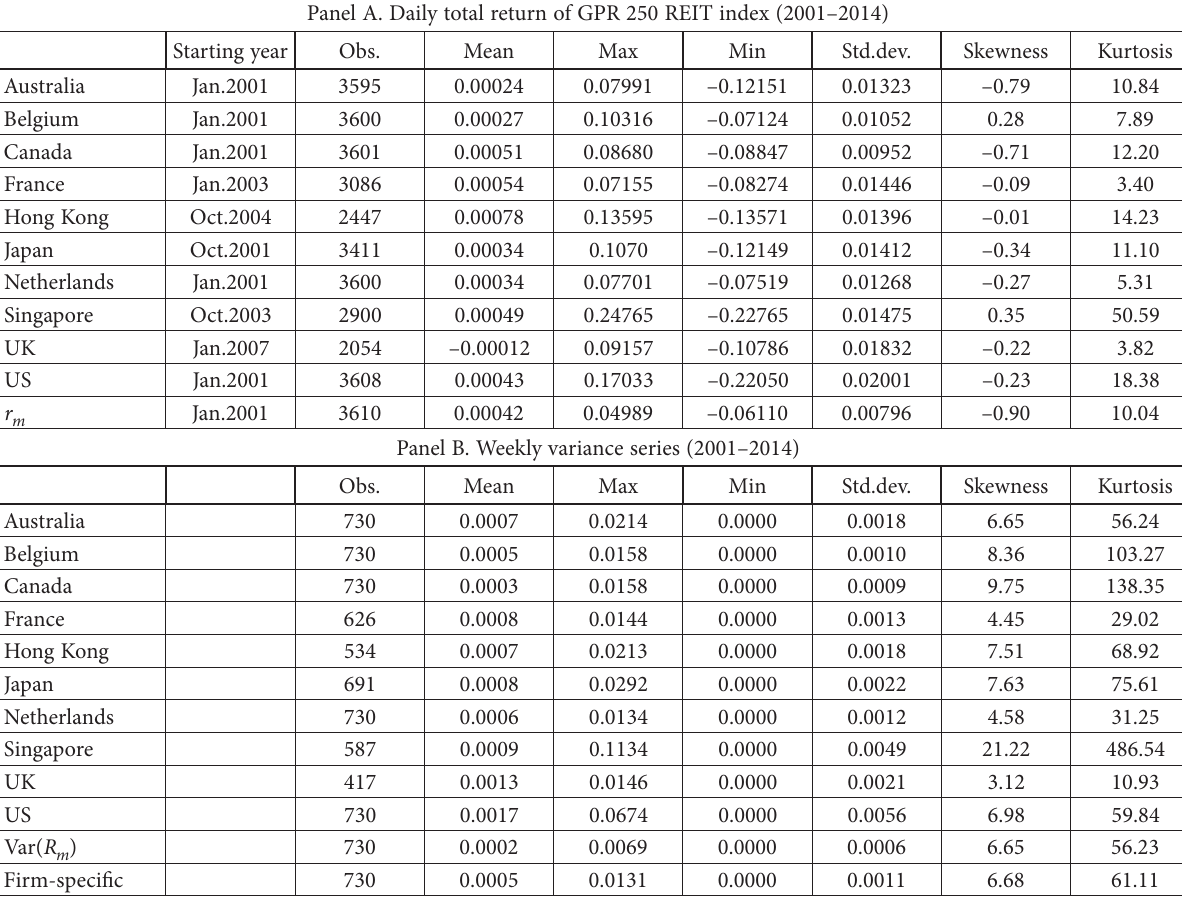
Table 1. Descriptive statistics of GPR 250 REIT